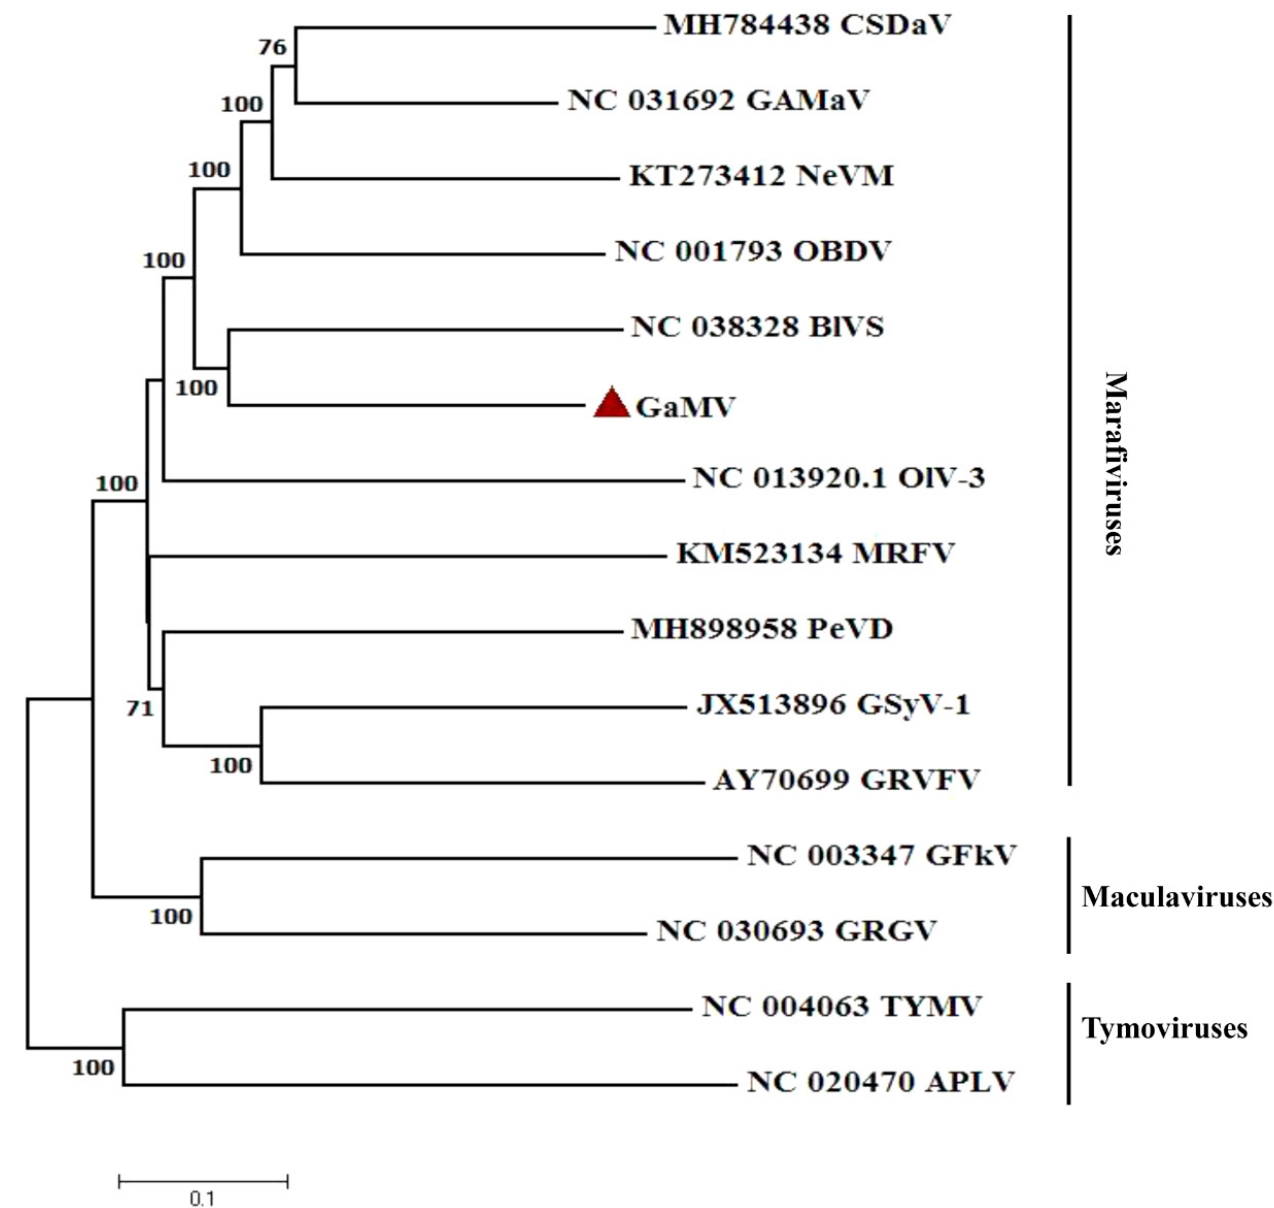
Figure 2. Neighbor-joining phylogenetic tree generated from the genomic sequences of grapevine-associated marafivirus (GaMV) and other members of the genera Marafivirus , Maculavirus and Tymovirus in the family Tymoviridae .